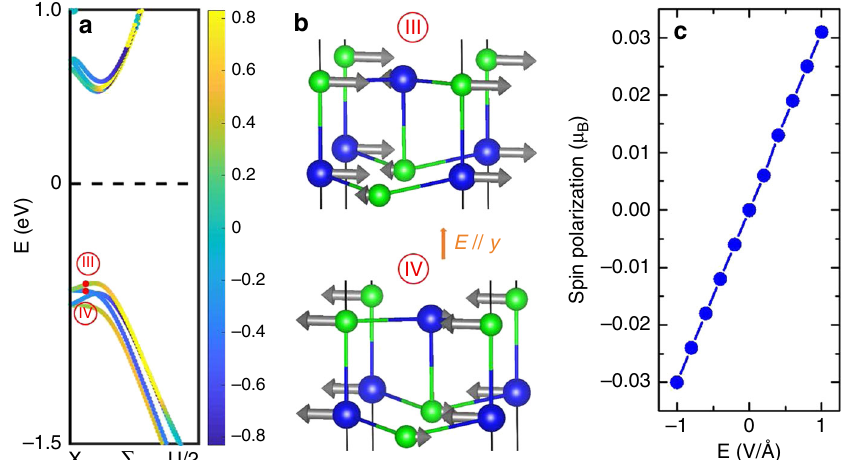
Fig. 5 Linear magnetoelectric coupling in reciprocal space in 2D SnTe thin fi lm. a The x components of spin polarizations when a 0.1 V/Å external electric fi eld parallel to y axis (i.e., normal to the fi lm) is added. The vanishing y and z components are not shown. b Local spin polarizations of Sn and Te atoms for the Bloch states marked with the red points III and IV in a . c Dependence of S x on the external electric fi eld for the Bloch state marked with the red “ antiferromagnetism of a Bloch state ” . The antiferromagnetic order satis fi es the little space group symmetry of the high- symmetry line Σ . In 2D SnTe, the magnetic fi elds acting on different atoms of the same kind (e.g., Sn) are opposite in direction for the k-point along the X-U direction, resulting in a band splitting and a net vanishing spin polarization (since local magnetic moments for the same kind atom at different positions are opposite) (see Fig. 1b and Supplementary Note 6). The presence of a staggered k-dependent magnetic fi eld along the X-U direction clearly appears in the k · p model restricted to the Σ line, which can be recast as H ¼ (cid:2) Δ τ y σ y þ B x k ð Þ σ x , where ð k Þ ¼ (cid:2) τ α k B x z B z .